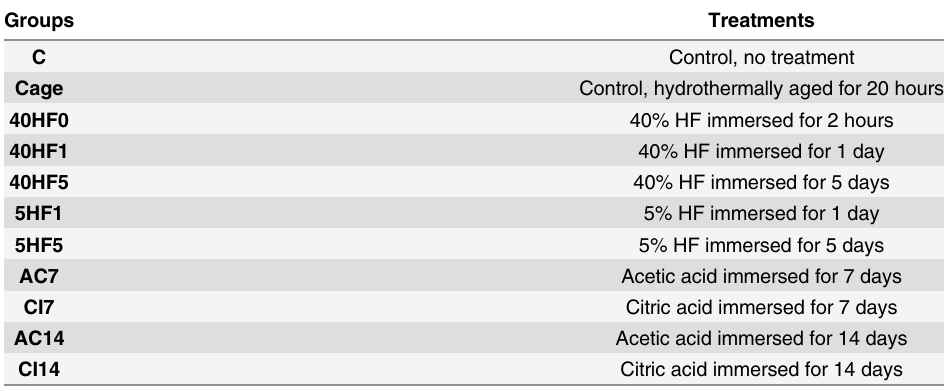
Table 1. Summarization of the treatments for all the experimental groups.